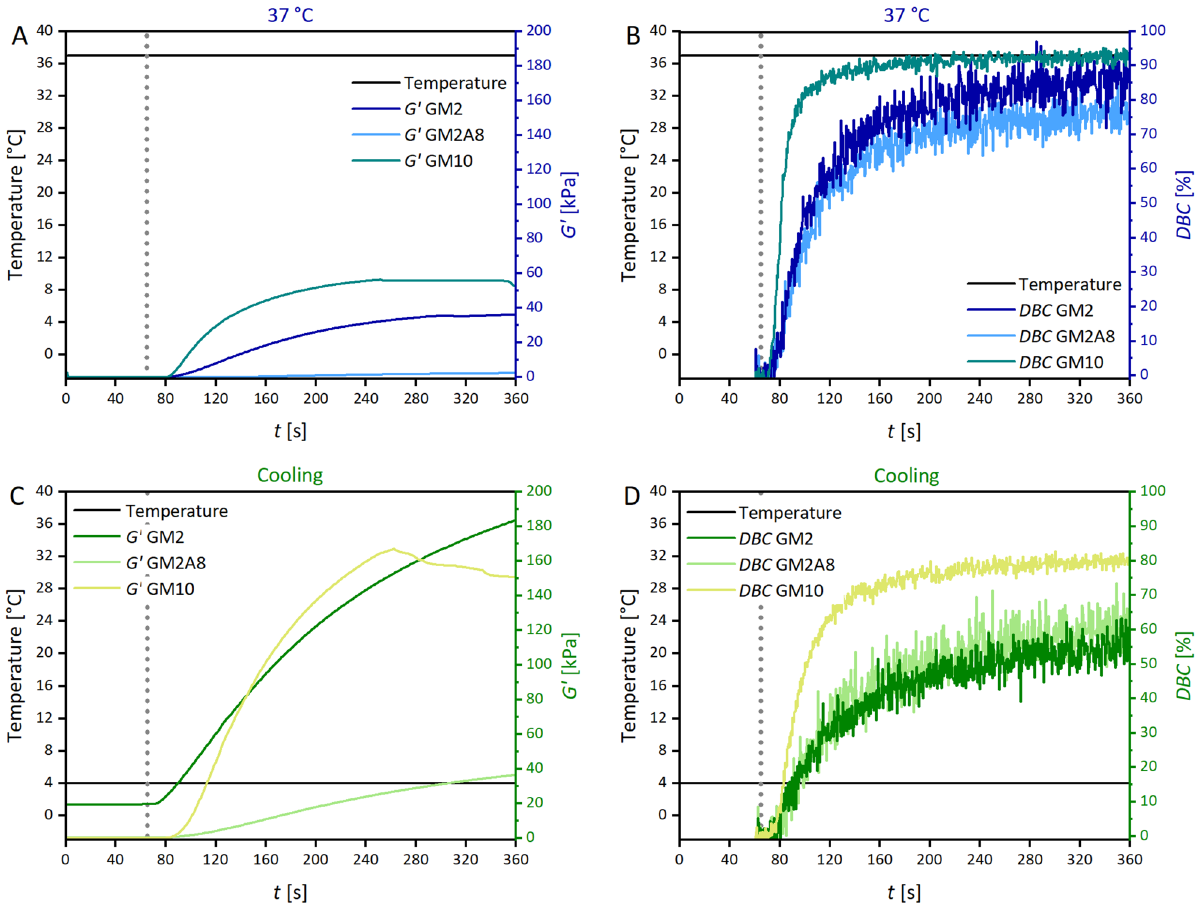
Figure 4. Real time-near infrared spectroscopy-photorheology data of GM2, GM2A8 and GM10 solutions. The storage moduli ( G ′ ) and double bond conversions ( DBC ) measured for chemical cross-linking at 37 °C (classical method) are shown in ( A , B ). G ′ and DBC measured during the sequential cross-linking procedure (cooling) are shown in ( C , D ), respectively. Note that the data in ( C , D ) were obtained directly after physical cross-linking shown in Fig. 3 using the same samples. The time axes in this figure therefore refer to the chemical cross-linking period only. Sequential cross-linking resulted in higher G ′ after chemical cross-linking and lower DBCs for all three gelatin derivatives. The grey dotted line indicates the start of UV-initiated cross-linking. The figure was created with Origin 2019b (https ://www.origi nlab.com/2019b ).